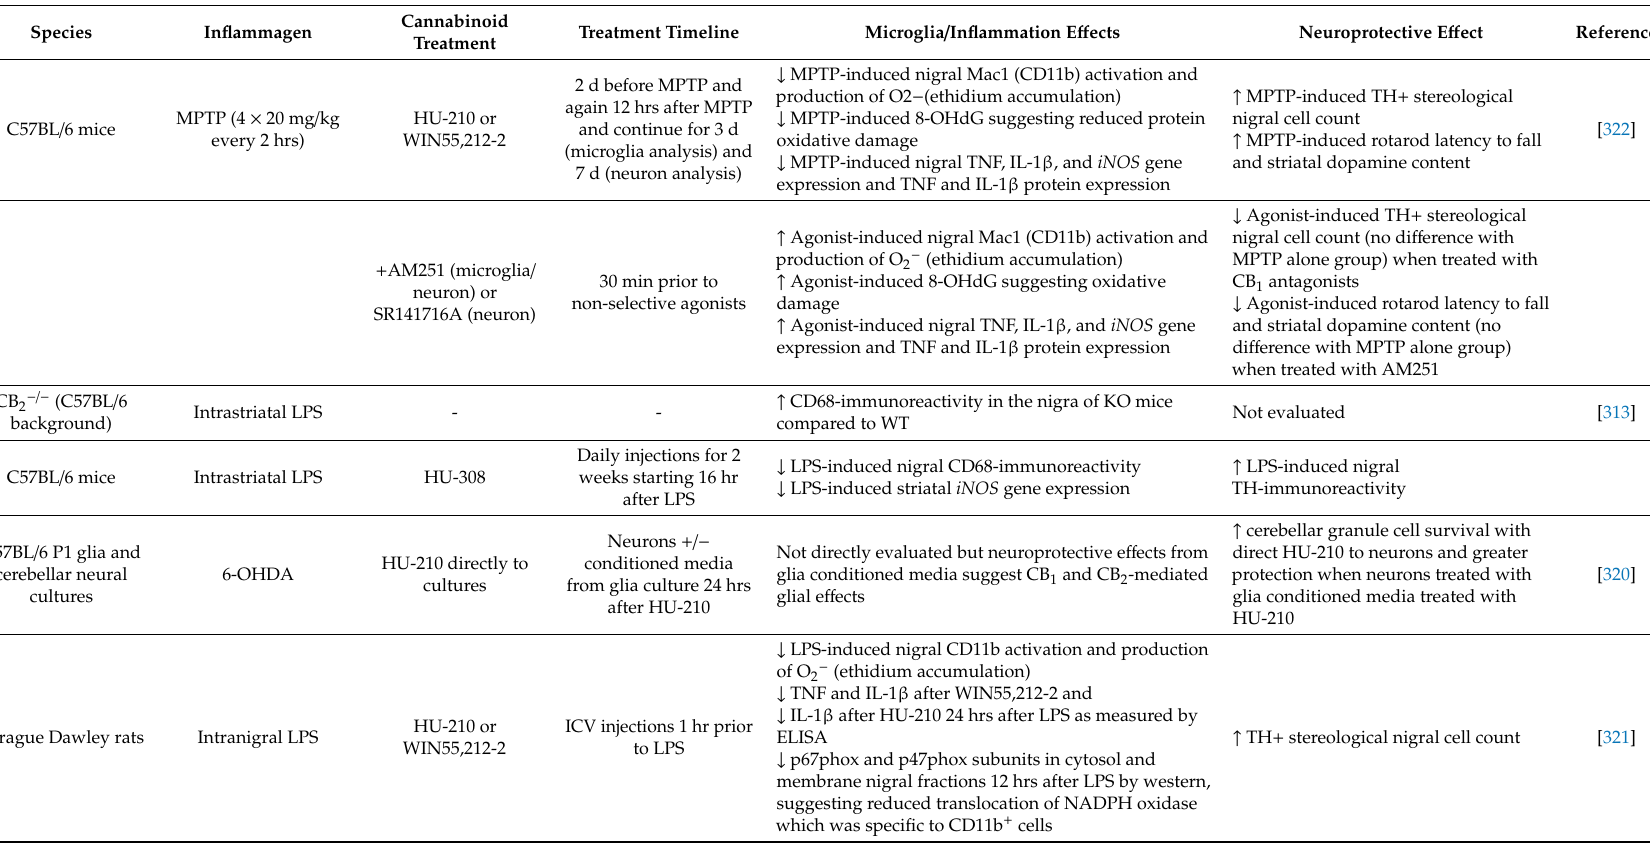
Table 2. Cannabinoid-mediated e ff ects on microglia / inflammation and neuroprotection in models of Parkinson’s disease. ↑ , increase. ↓ , decrease. ICV, intracerebroventricular. 8-OHdG, 8-hydroxy-2- deoxyguanosine. LPS, lipopolysaccharide. MFB, medial forebrain bundle. CB 1 / 2 non-selective agonist: WIN55,212-2, HU-210. CB 1 antagonist: AM251, SR141716A. CB 2 selective agonist: HU-308, JWH015. CB 2 selective antagonist: JTE907, AM630. CB 2 inverse